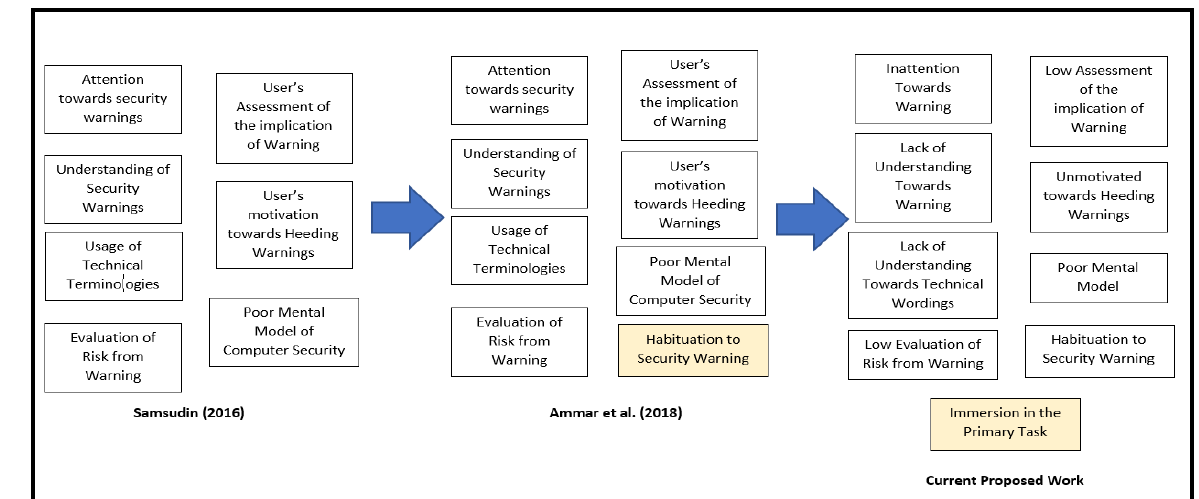
Figure A3. Flow and differences of security warning classifications.